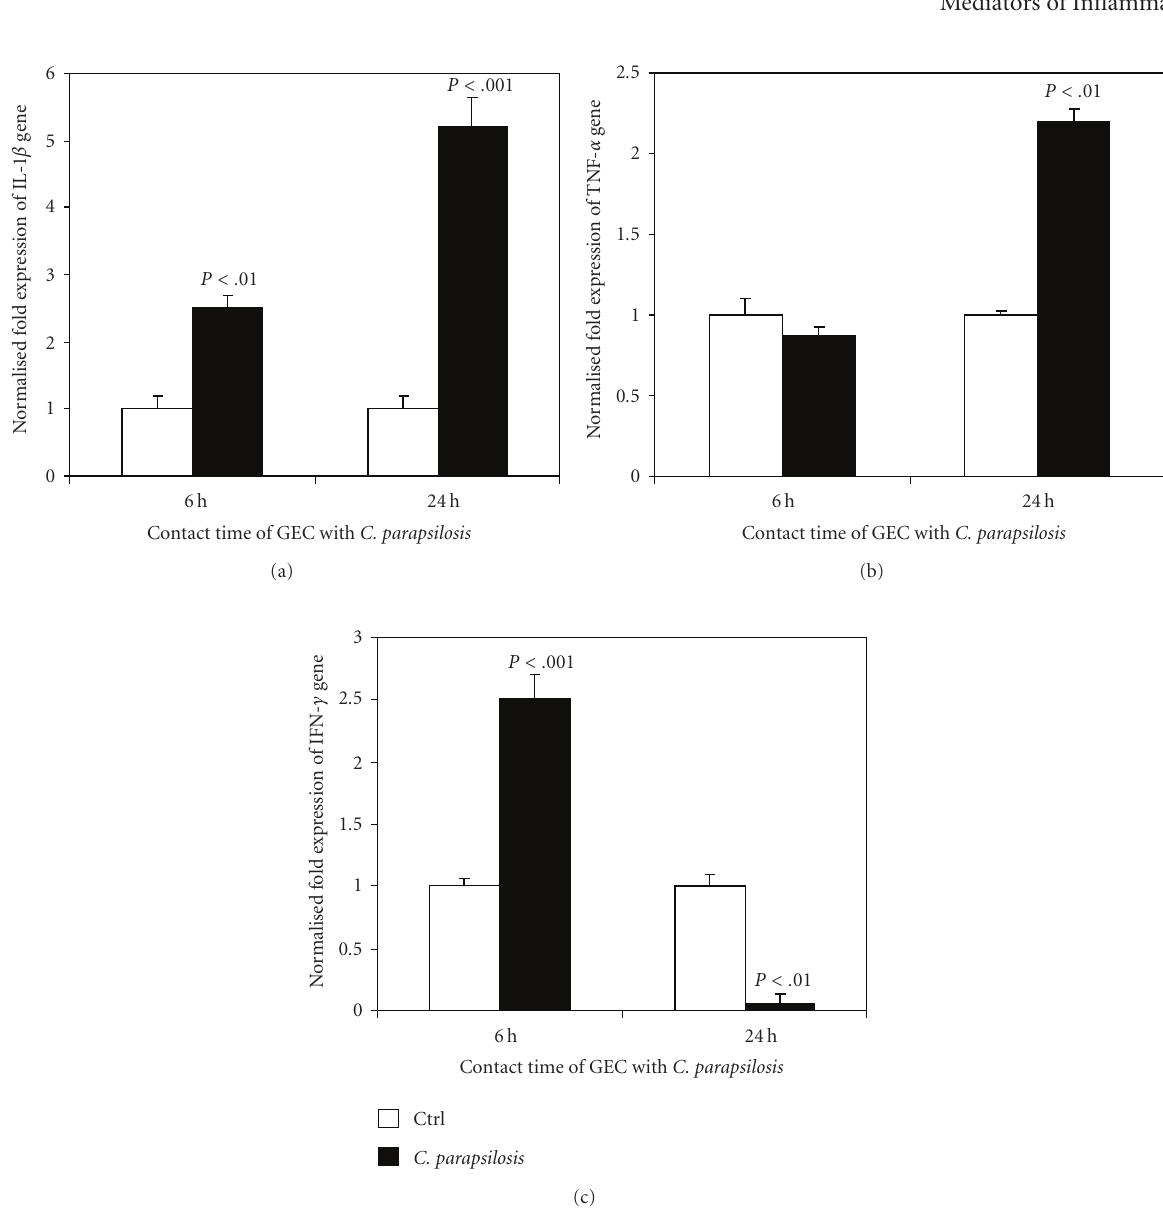
Figure 8: Quantification of mRNA expression levels of IL-1 β , TNF α , and IFN γ by gingival epithelial cells following infection with C. parapsilosis . Gingival epithelial cells were cultured with or without C. parapsilosis for 6 and 24 hours. Total RNA was extracted from the cells following each culture period and was used for quantitative RT-PCR of the IL-1 β , TNF α , and IFN γ genes, as described in Section 2. Results are presented as a fold expression of the gene in the test sample compared to this gene expression in the control. Data are expressed as means ± SD from triplicate assays of three di ff erent experiments. (a) IL-1 β expression, (b) TNF α expression, and (c) IFN γ expression. GEC: gingival epithelial